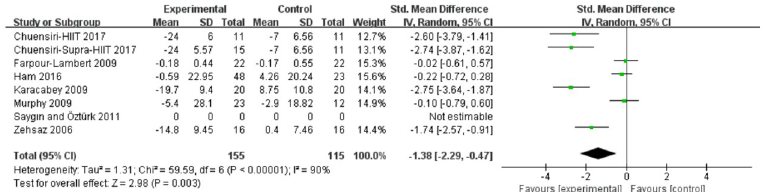
Fig 6. Forest plot of comparison: Low-density lipoproteins.